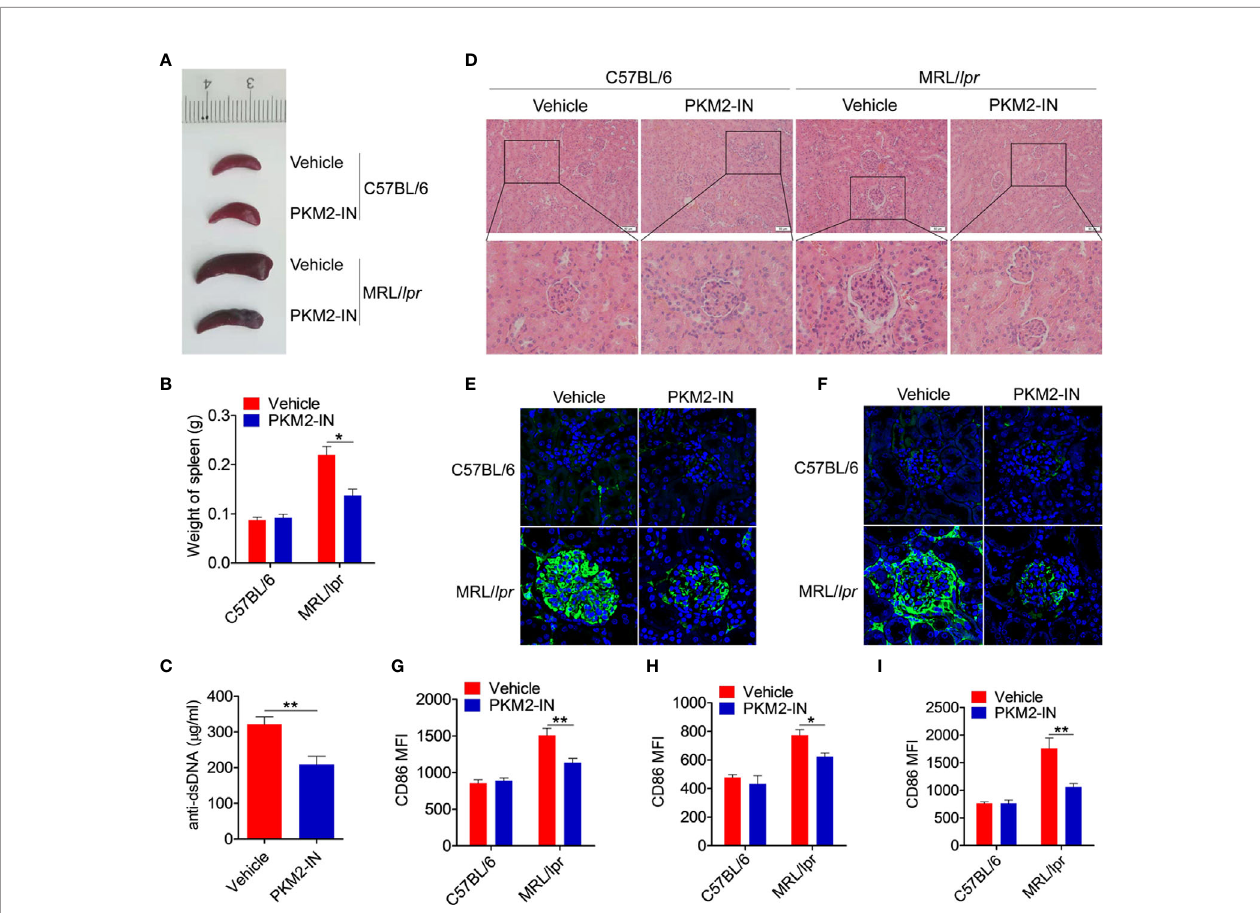
FIGURE 8 | Pharmaceutical inhibition of PKM2 relieves the lupus-symptoms in MRL/ lpr mice. (A) Representative images of marked splenomegaly in all groups of mice. (B) Weight of spleen in all groups of mice. (C) ELISA analysis of the anti-dsDNA antibody in serum from PKM2-IN- or vehicle-treated MRL/ lpr mice. (D) H&E staining of the kidney sections from all groups of mice. (E, F) Immuno fl uorescence staining to detect IgG (E) and IgM (F) deposit in the kidney sections. (G – I) FACS analysis of CD86 expression on splenic macrophages (G) , DCs (H) and B cells (I) in all groups of mice. The data are shown as the means ± SEM (n=6 mice/group) and are representative of three independent experiments. * p < 0.05, ** p < 0.01, as determined by ANOVA tests or t